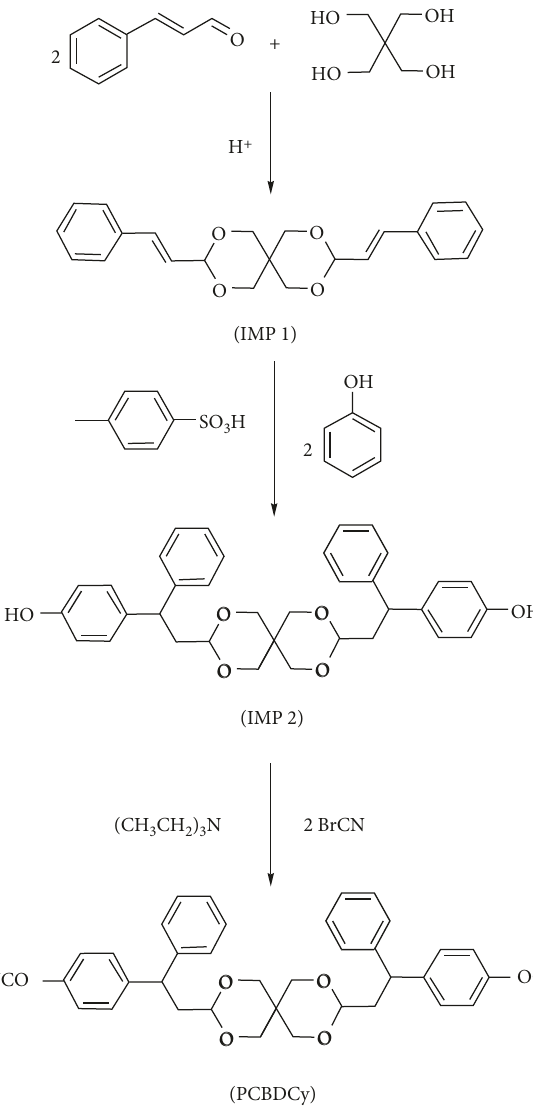
Scheme 1: Synthesis procedure of